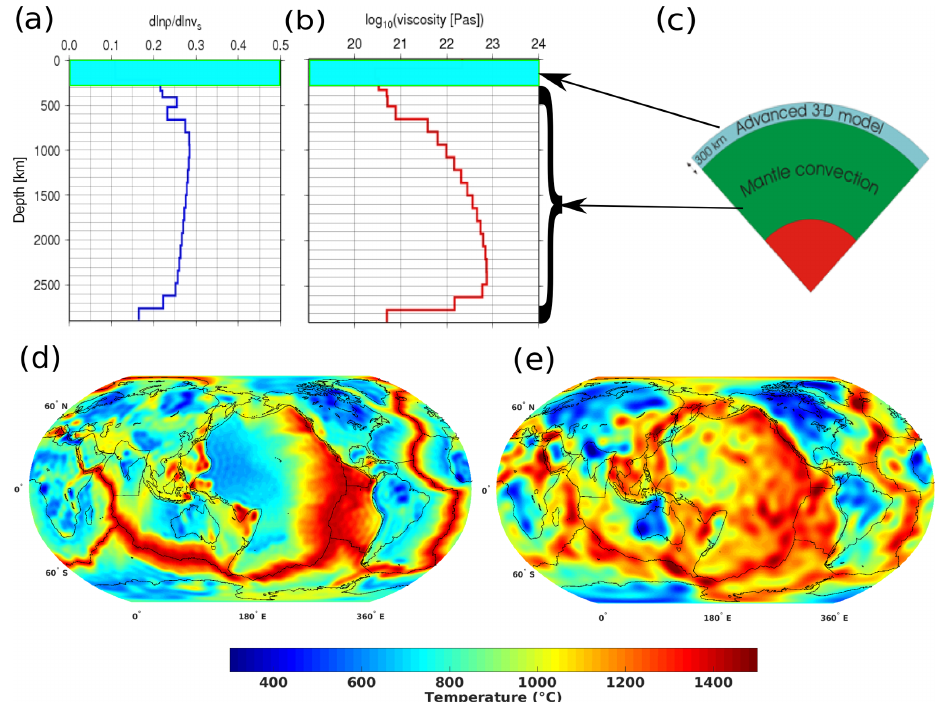
Figure 1. Adopted from Osei Tutu et al. (2018). (a) Depth-dependent scaling profile of S-wave velocity to density; (b) radial mantle viscosity structure (Steinberger and Calderwood, 2006) and (c) a schematic diagram of the numerical method that couples the 3-D-lithosphere– asthenosphere code SLIM3D (Popov and Sobolev, 2008) to a lower mantle spectral flow code (Hager and O’Connell, 1981) at a depth of 300km. Panels (d) and (e) show the thermal structure at a depth of 80km from two 3-D thermal models adopted in this study. (d) TM1, a heat flow-based thermal structure inferred from the TC1 model of Artemieva (2006) in the continents and the seafloor age model of Müller et al. (2008) in the oceanic areas. (e) TM2, the thermal structure of the upper mantle inferred from the S-wave tomography model SL2013sv of Schaeffer and Lebedev (2013). The “ringing” visible in panel (d) is an artifact introduced by smoothing sharp boundaries with a spherical harmonic